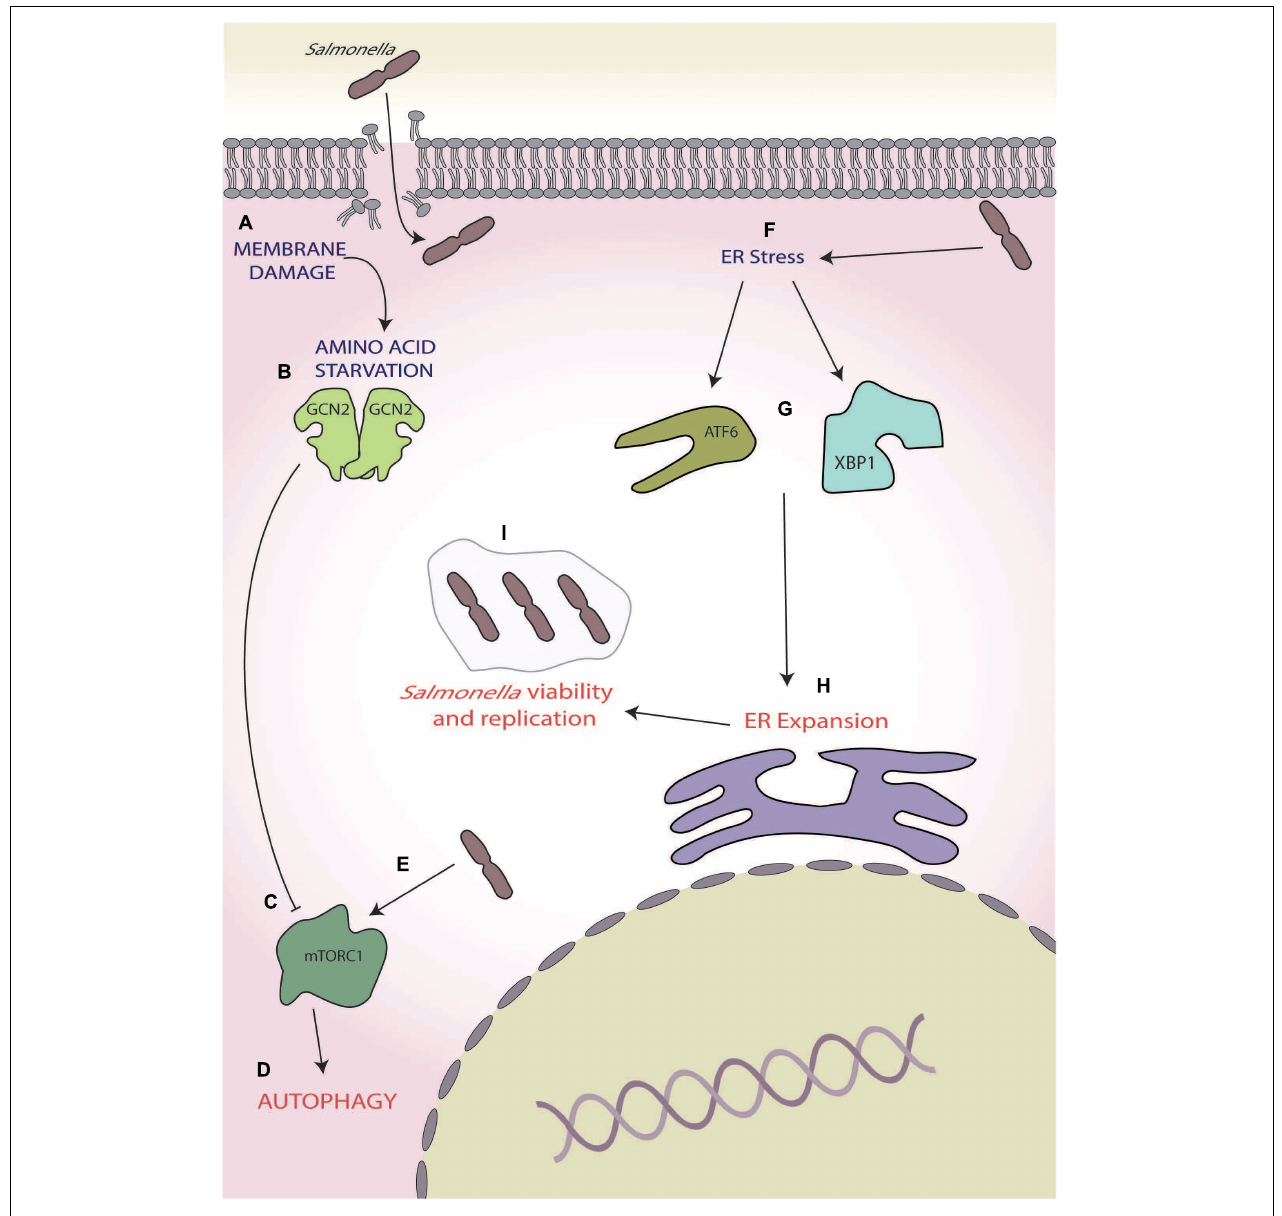
FIGURE 4 | Salmonella . (A) Membrane damage caused during Salmonella internalisation induces amino acid (AA) starvation, (B) leading to general control non-depressible 2 (GCN2) activation, and (C) inhibition of mammalian target of rapamycin complex 1 (mTORC1), and (D) ultimately inducing autophagy. (E) During later-stage infection, Salmonella reactivates mTORC1, thereby inhibiting autophagy. (F) Salmonella also induces endoplasmic reticulum (ER) stress, (G) activating the unfolded protein response (UPRs) ATF6 and X-box binding protein 1 XBP1 arms, (H) leading to expansion of the ER, and (I) which increases intracellular Salmonella viability and